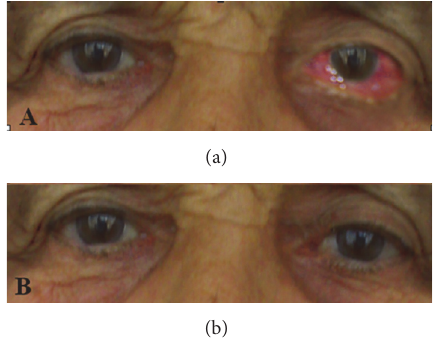
Figure 1: Photographs of the patient. (a) Before the treatment for carotid cavernous sinus fistula showing left chemosis and exophthalmos. (b) After the treatment showing improved chemosis and exophthalmos.